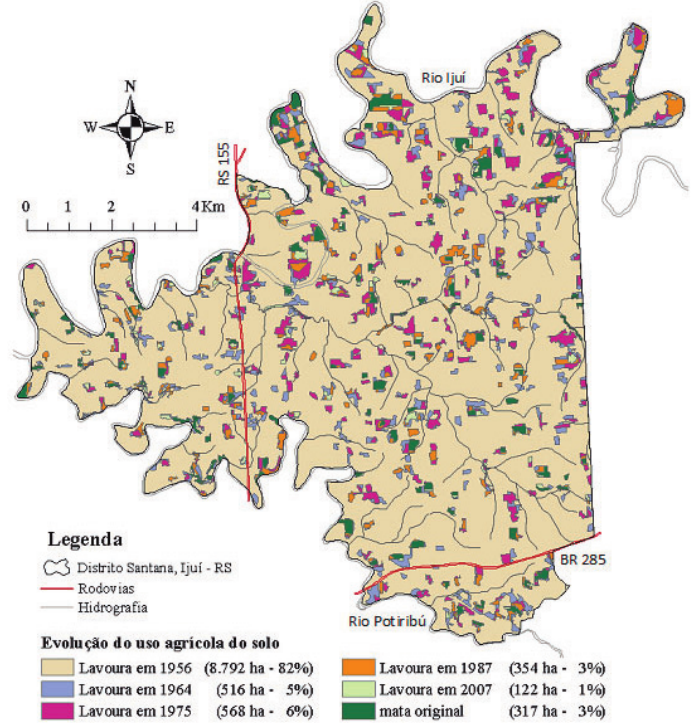
Figura 3. Mapa de evolução de uso agrícola do solo no distrito santana, ijuí-rs, de 1900 (condição original) a